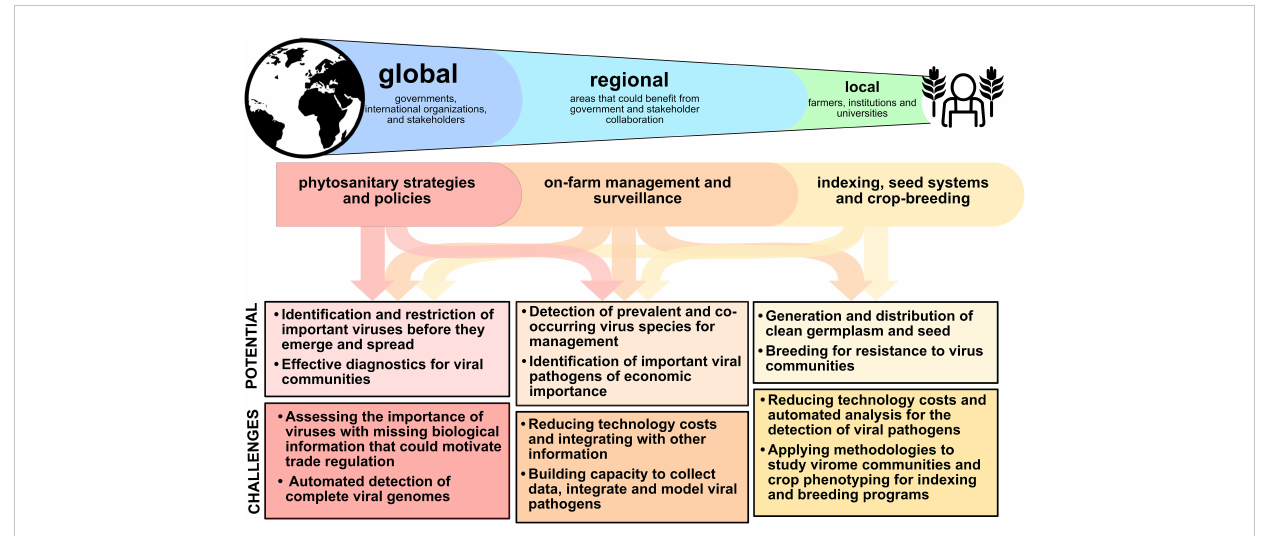
FIGURE 1 Virome analysis reveals complex interactions in mixed and single infections, with impacts from global to local scales. Translating information at each scale has both important potential as well as challenges for implementation. Effective translation can improve on-farm management, crop breeding and seed systems, and phytosanitary